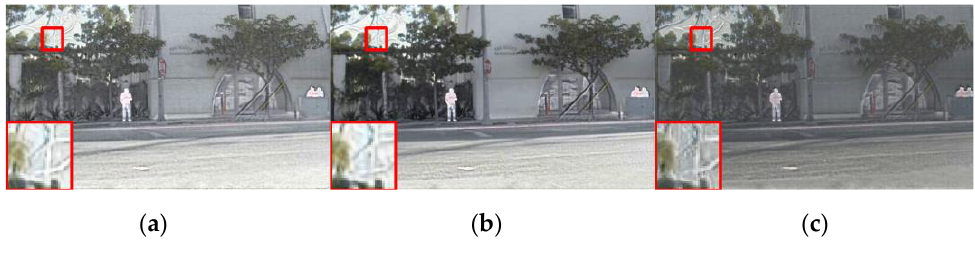
Figure 11. Experimental results of a different number of couplets, ( a ) 1, ( b ) 2; ( c ) 3.